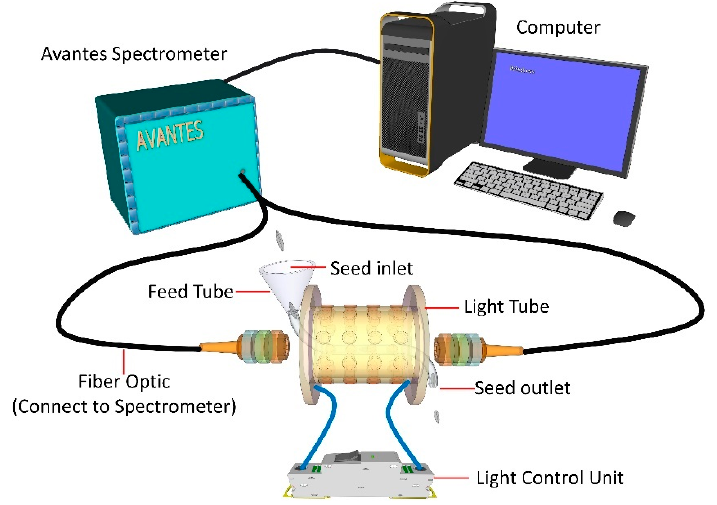
Figure 1. The high-throughput near-infrared spectral acquisition system of individual rice